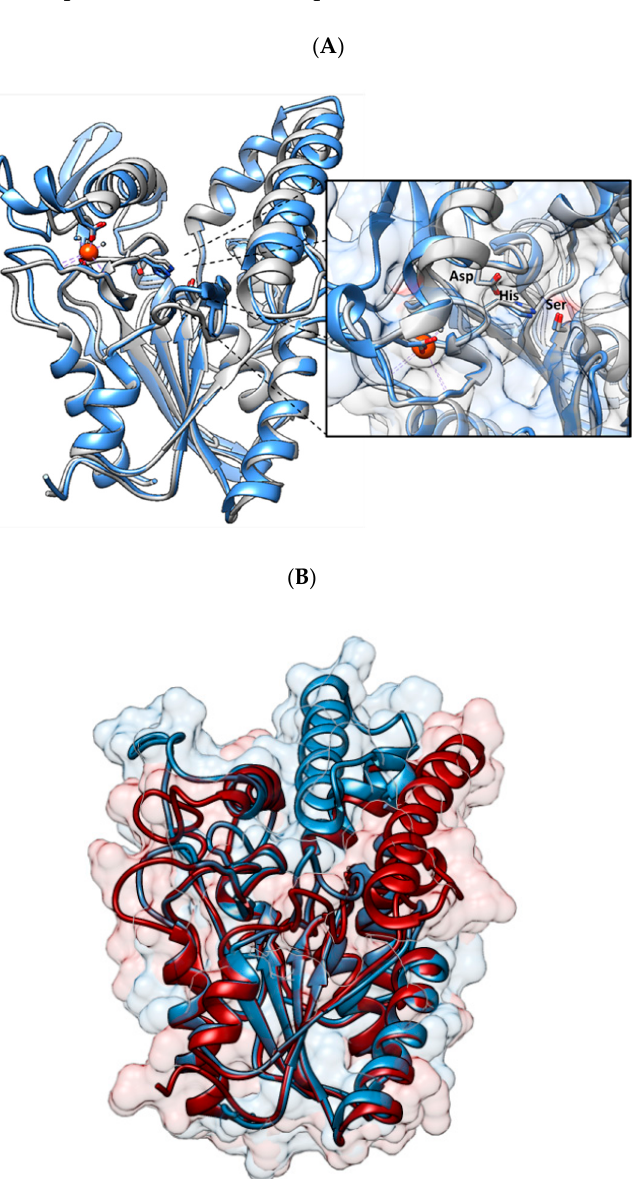
Figure 2. ( A ) Standard α / β hydrolase fold of the superposed structures of the lipases from Burkholderia cepacia (blue) (PDB:1YS1) and Pseudomonas aeruginosa (gray) (PDB:1EX9). Zoom-in of the modeled catalytic site and the calcium ion (in red); ( B ) molecular model of the metagenomic lipase LipC12 (PDB:6CL4) with the structure superposed in the “open” (red) and “closed” (blue) form.